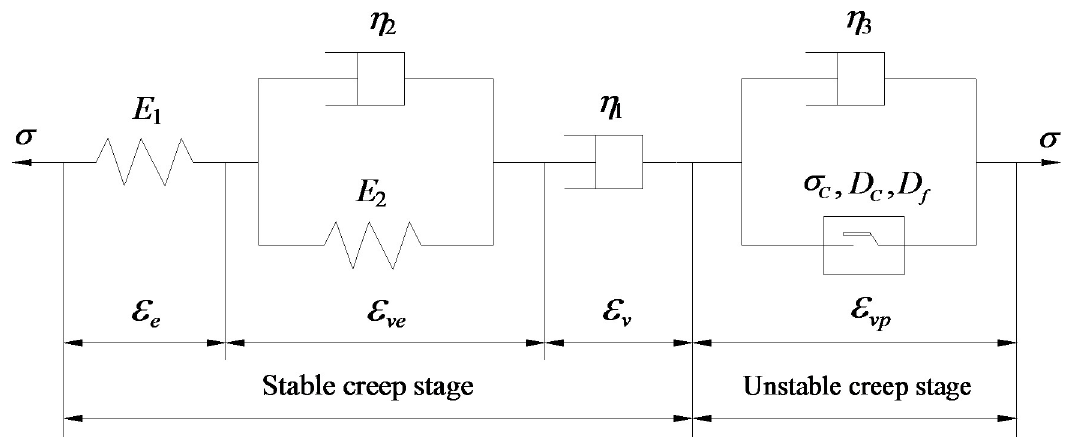
Fig 8. Schematic diagram of D-NVEP